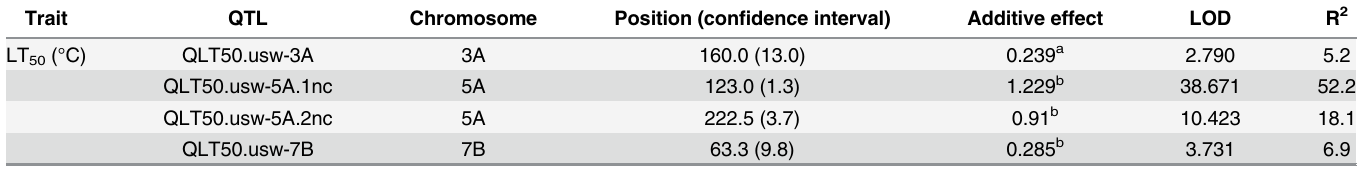
Table 5. QTL of Cappelle Desprez x Norstar detected in controlled Environment Trials. Position (cM) is given at the peak of LOD with the confidence interval (cM). Additive effect is given according to the parent, Norstar (a) and Cappelle Desprez (b).